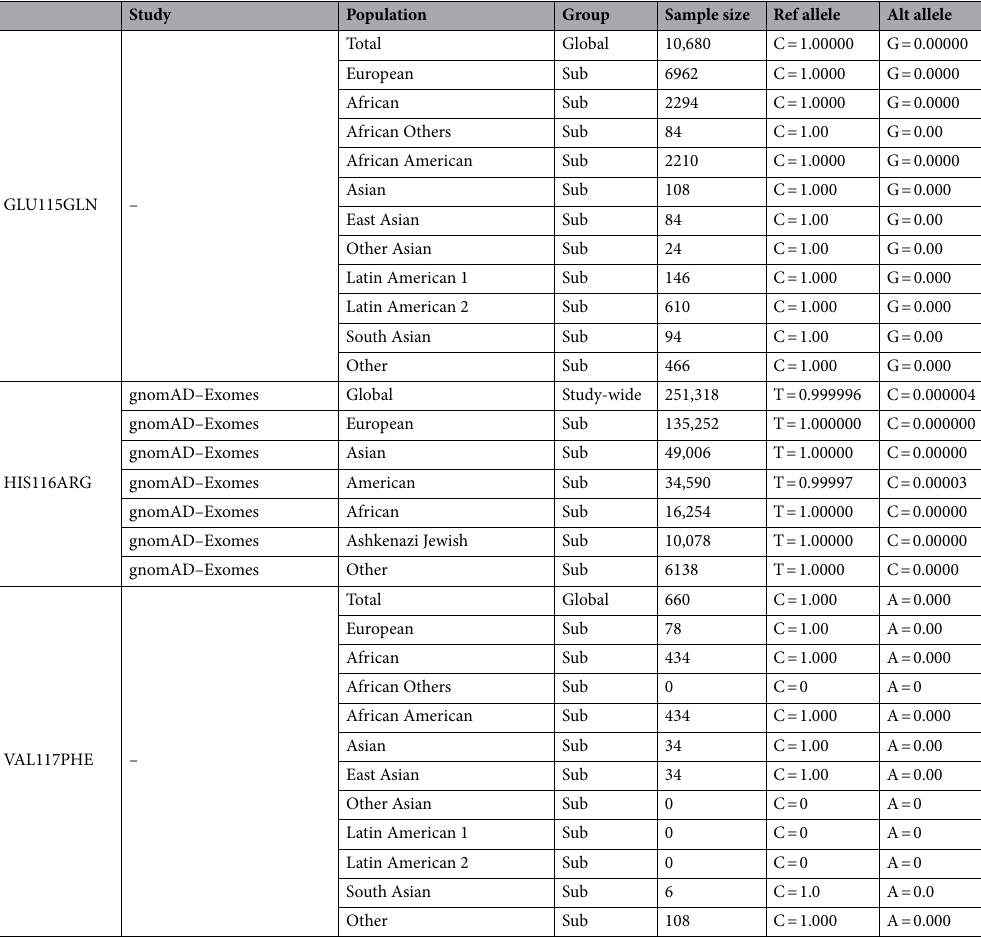
Table 3. Allele frequency for the SNPs of BLC6 gene at positions that interact with BI-3802 and DB11611.